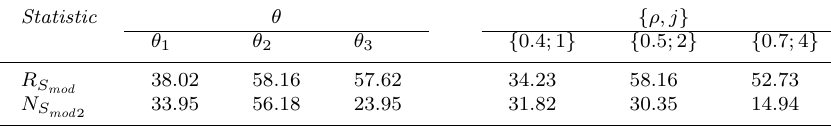
Table 2. Estimated power (%) for g 1 and g 2 alternative defined in (3.1) and (3.2) of R S mod (independent case), N